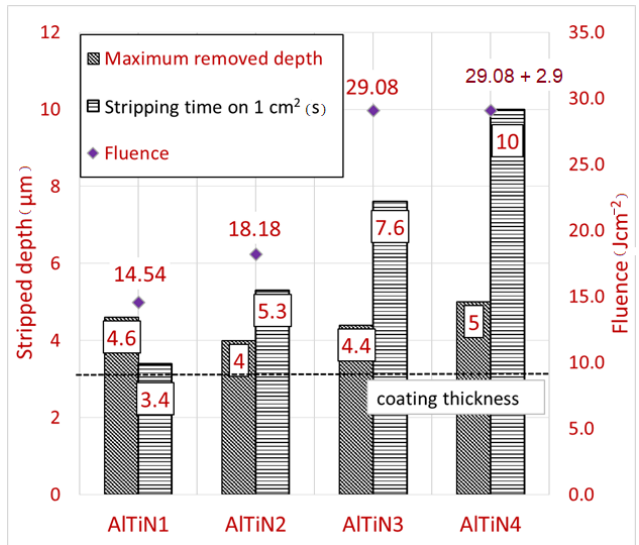
Figure 3. Bar chart of removed depth and working time for AlTiN coating stripping.